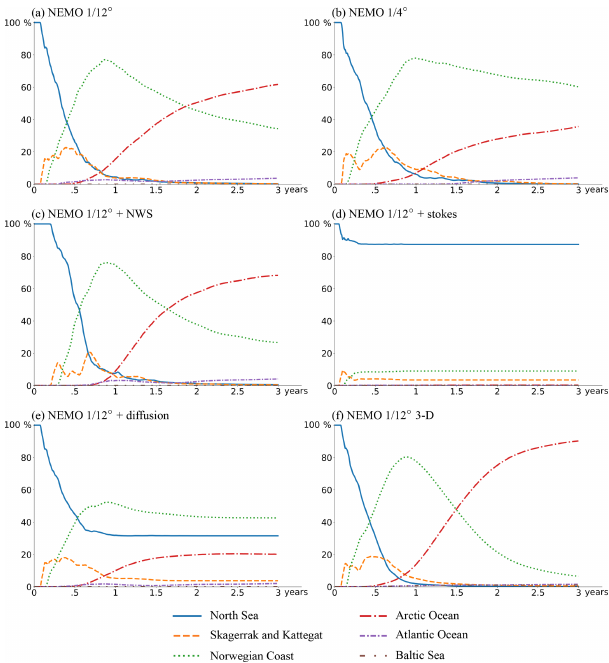
Figure 8. Evolution of the distribution of floating microplastic (a– e) and passive 3-D particles (f) in the six zones (Fig. 5) as a function of particle age.